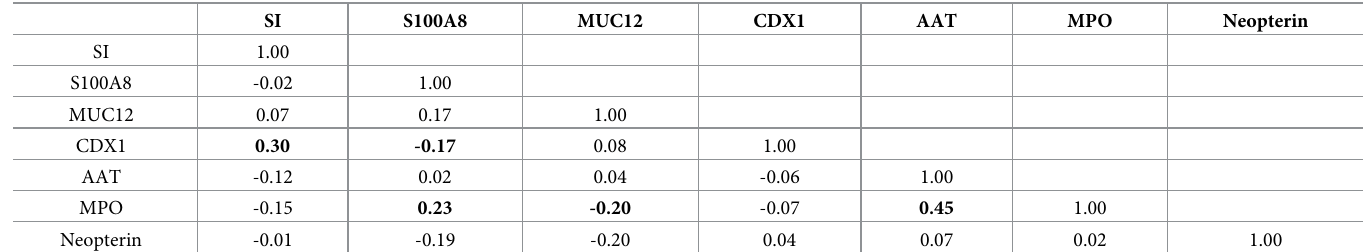
Table 3. Spearman correlation coefficients between biomarkers. Coefficients significant at the 0.05 level are bolded.